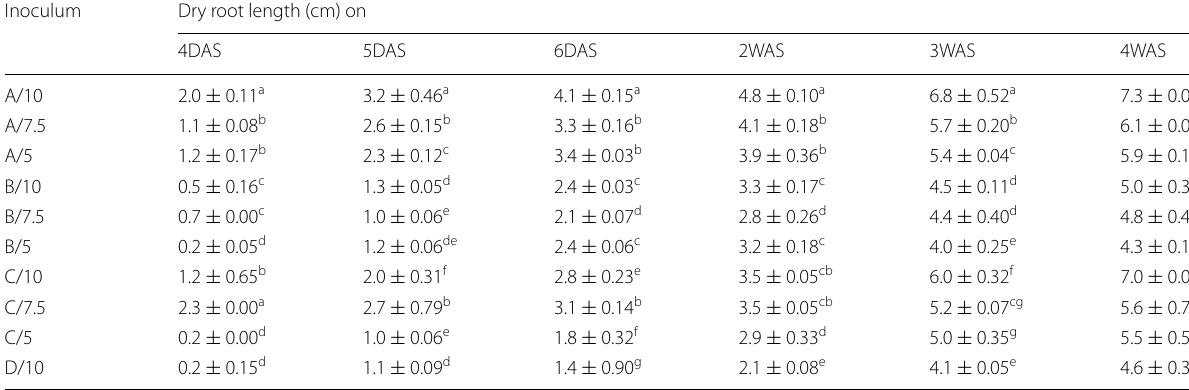
DAS Days after sowing, WAS Weeks after sowing. Results with similar alphabetic superscripts on same column did not differ from each other ( p >0.05). A10, A7.5 = = and A5.0 10 ml, 7.5 ml and 5.0 ml of Bacillus sp., respectively. B10, B7.5 and B5.0 = ml and 5.0 ml of Klebsiella sp ., respectively. D10 10 ml of control. =